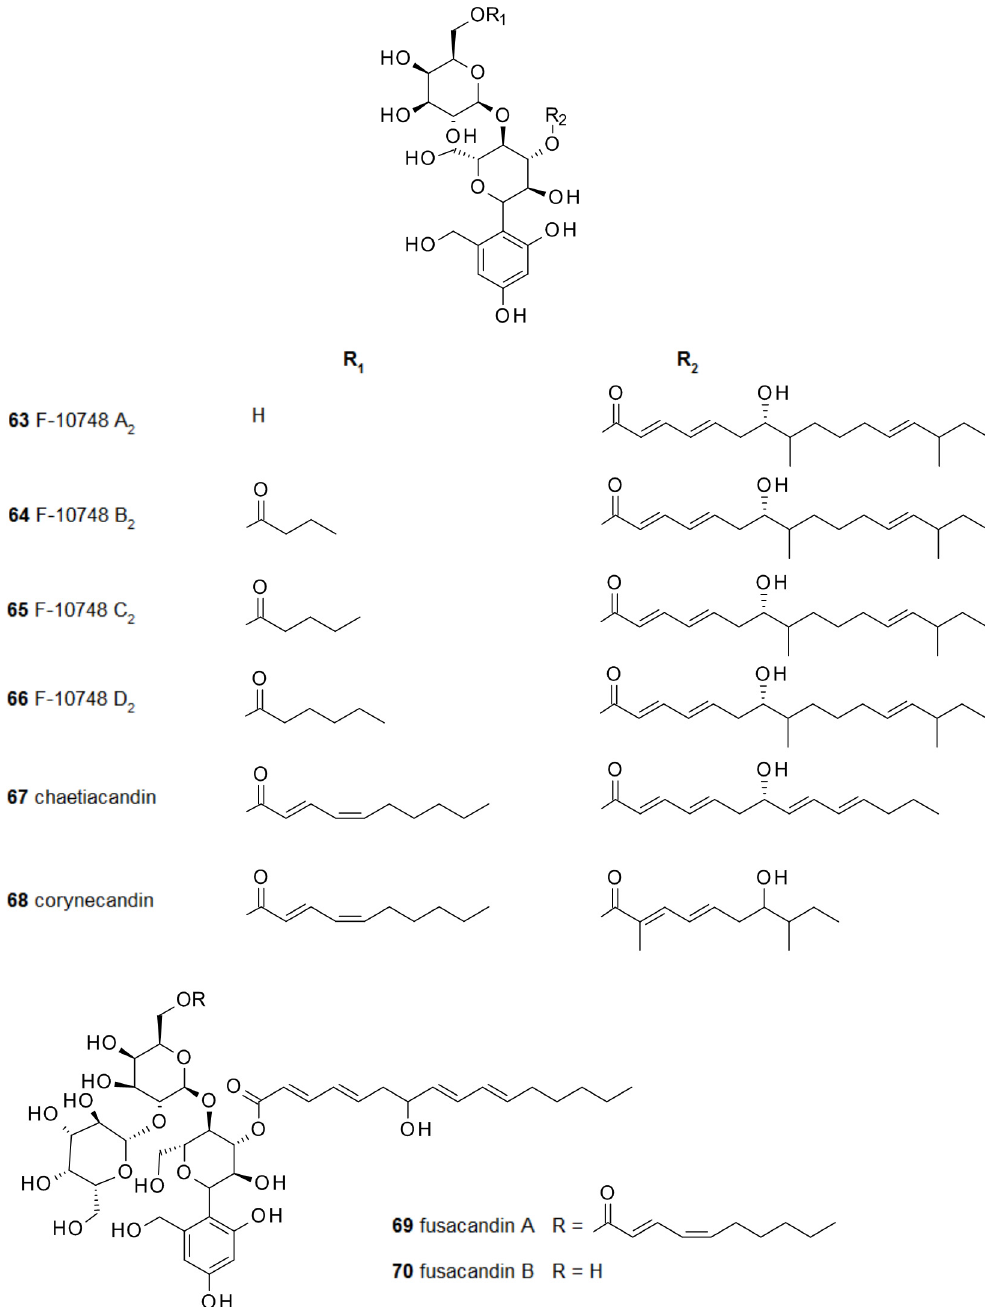
Figure 7. Antifungal papulacandins and the galactosylated fusacandins lacking the spiroketal moiety.